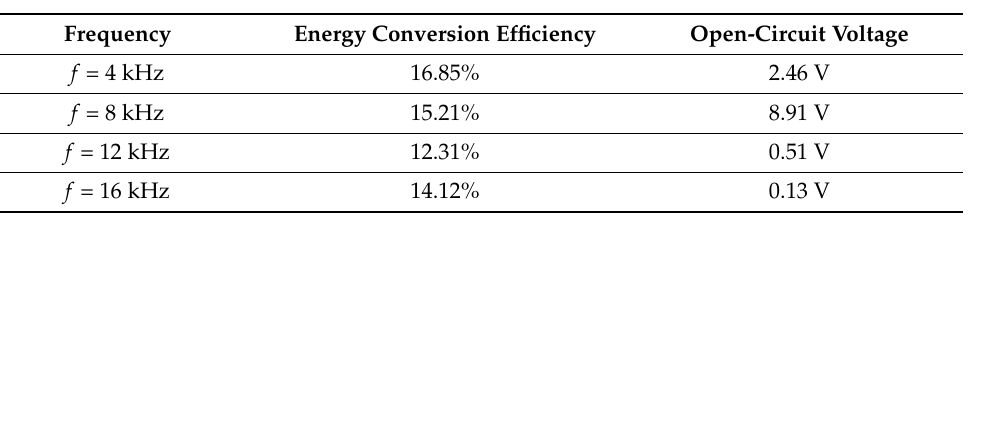
Figure 4. Energy conversion efficiency enhanced designs for variant excitation frequencies. ( a ) f = 4 kHz; ( b ) f = 8 kHz; ( c ) f = 12 kHz; ( d ) f = 16 kHz. Table 2. The optimized results of the open-circuit voltage enhanced designs.